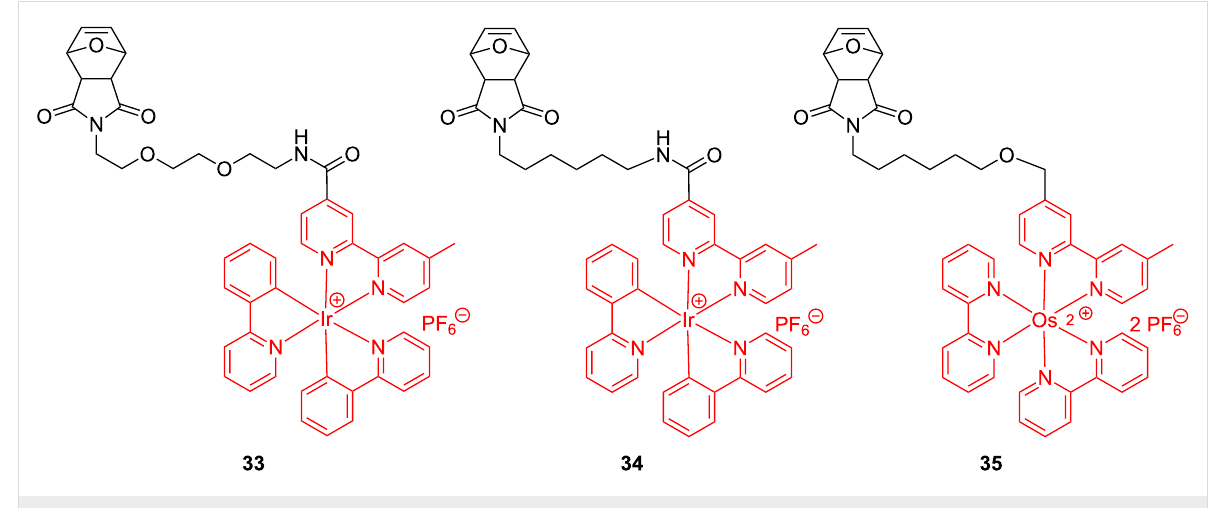
Scheme 14: Monomers for Ir- and Os-containing ROMP polymers.